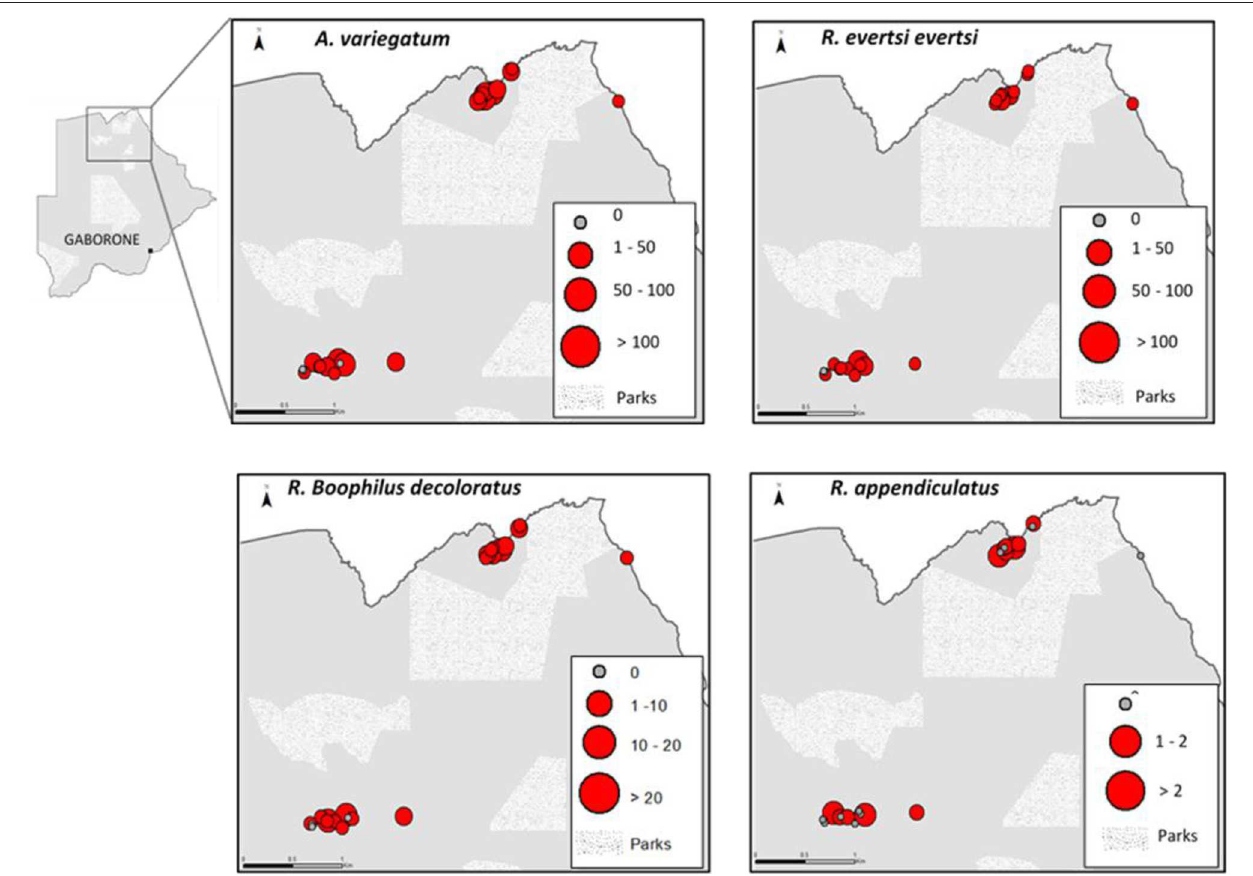
Influence of Age, Sex, and Breed There was a significant difference ( p ≤ 0.05) between age of cattle that were infested with A . variegatum , R . ( B. ) decoloratus , and H . truncatum with adults having